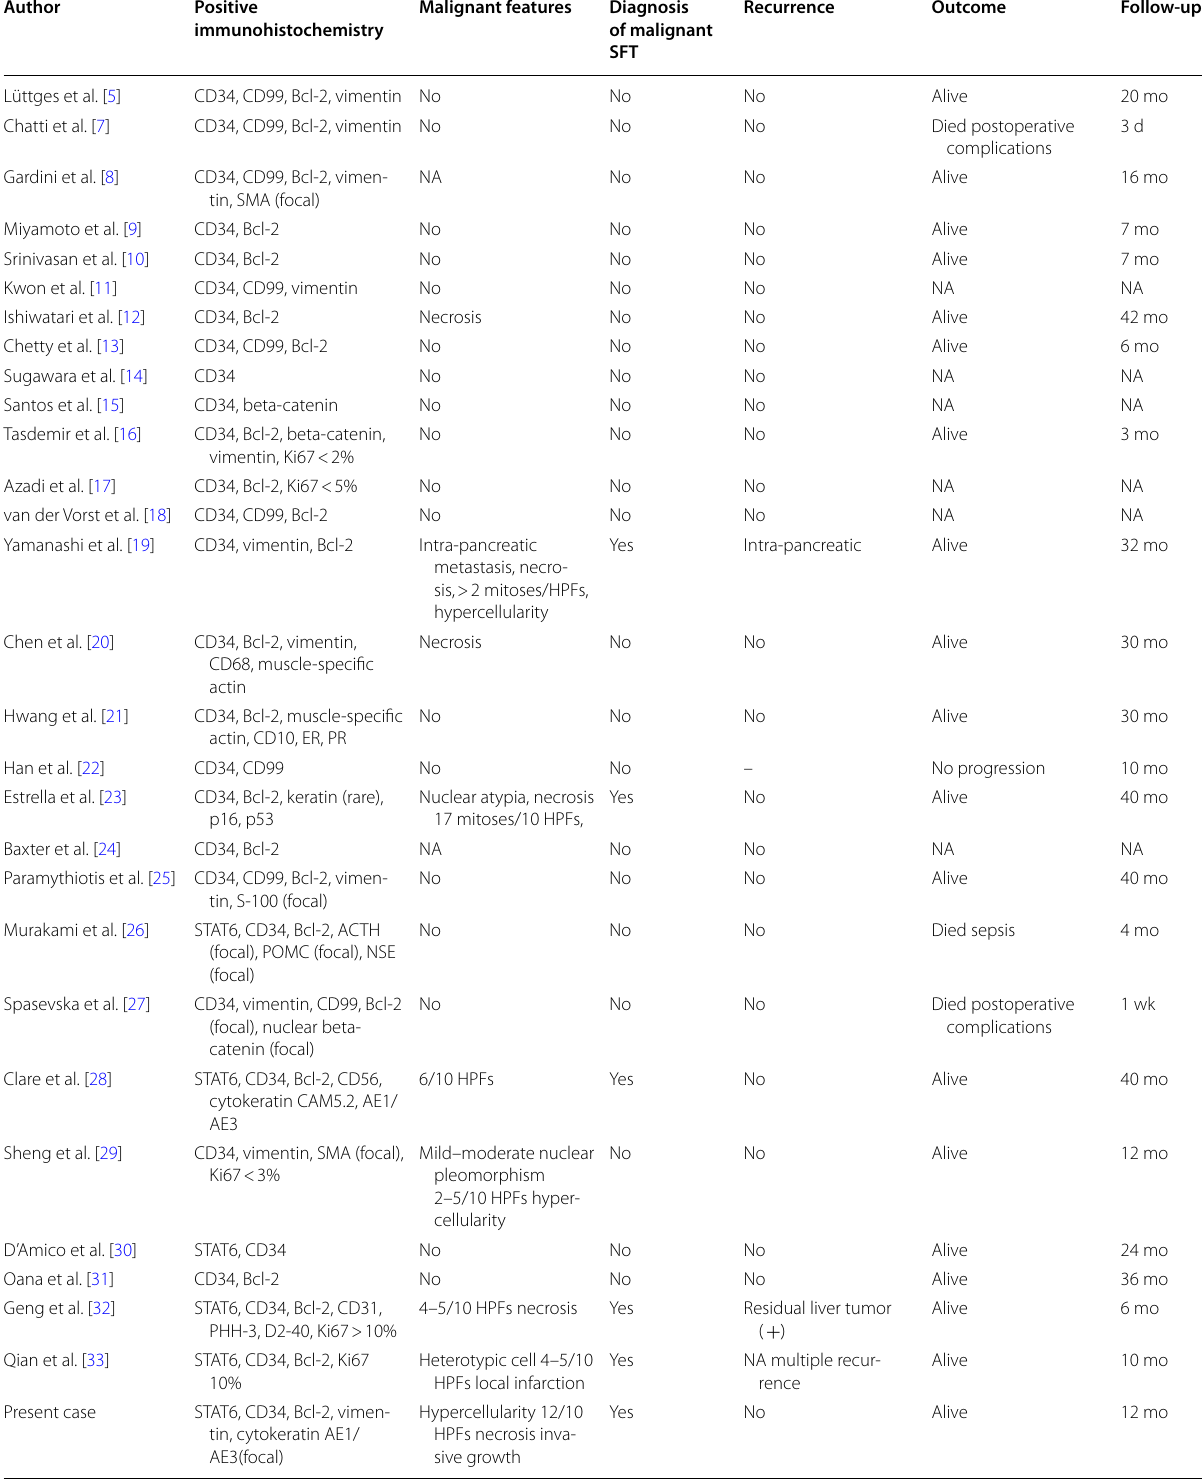
SFT solitary fibrous tumor, HPFs high-power fields, CD cluster of differentiation, Bcl-2 B cell CLL/lymphoma-2, STAT6 signal transducer and activator of transcription 6, ER estrogen receptor, PR progesterone receptor, SMA smooth muscle actin, NA not